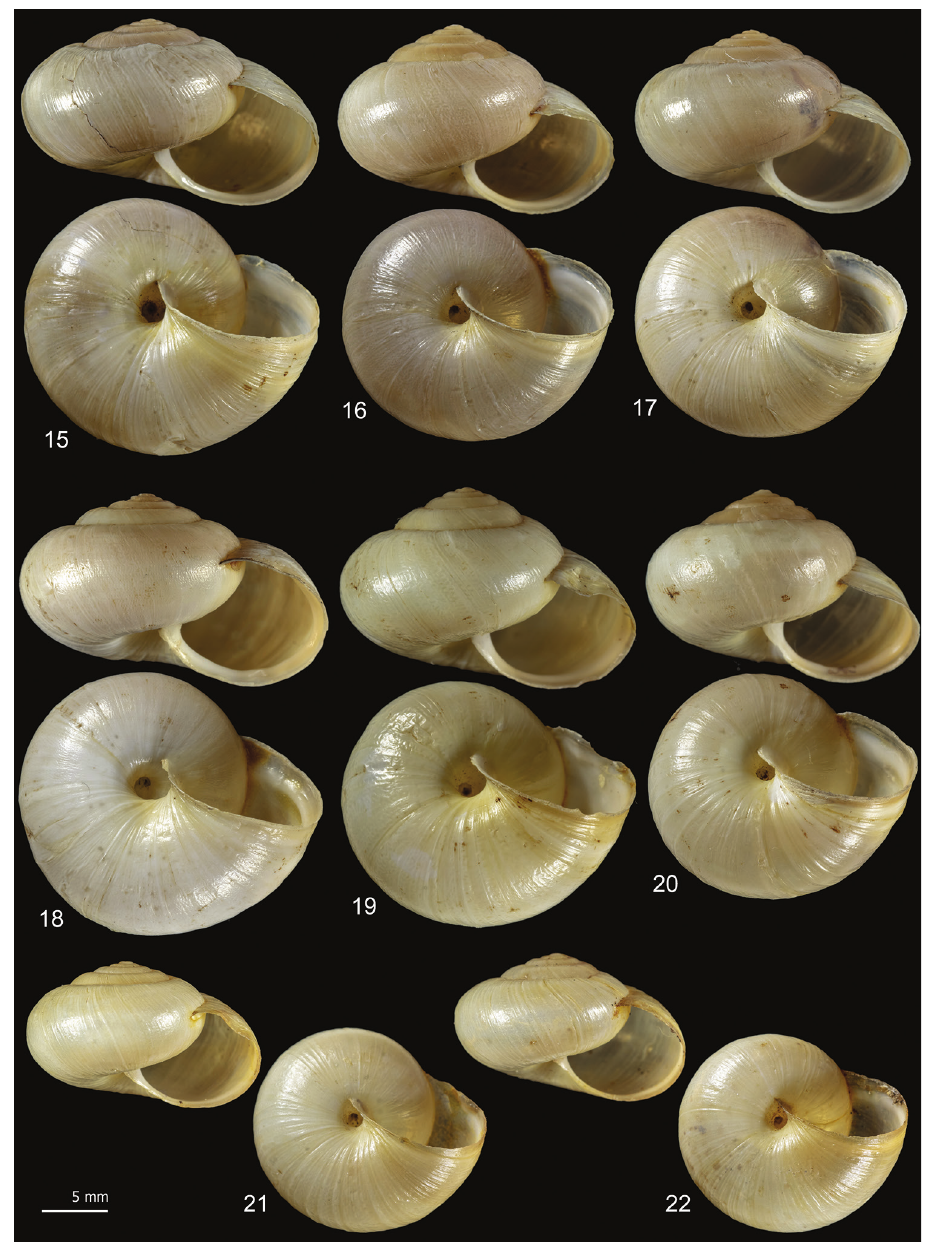
Figures 15–22. Shell variability in Monacha pantanellii from Lago del Turano [Tur2] (FGC 41654) ( 15–17 ), Via Salaria, Ornaro Alto [Alt] (FGC 41553) ( 18–20 ) and Vallonina [Val] (FGC 25345) ( 21, 22